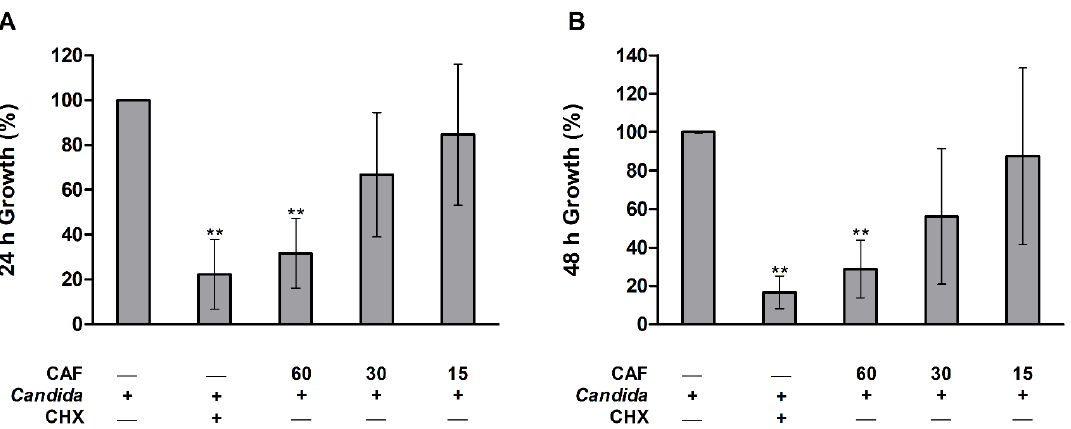
Figure 1. Microdilution test for caffeine (CAF) effects against C. albicans growth showing the per- centage (%) growth calculated from the measured optical density (OD) of different groups measured at 620 nm. ( A ) After 24 h incubation at 37 ◦ C with broth media. ( B ) After 48 h incubation at 37 ◦ C with broth media. Data are expressed as mean ± SD ( n = 6) and statistically analyzed using one-way ANOVA followed by Tukey’s post hoc test. The significance was considered when ** p ≤ 0.01 as compared with control.